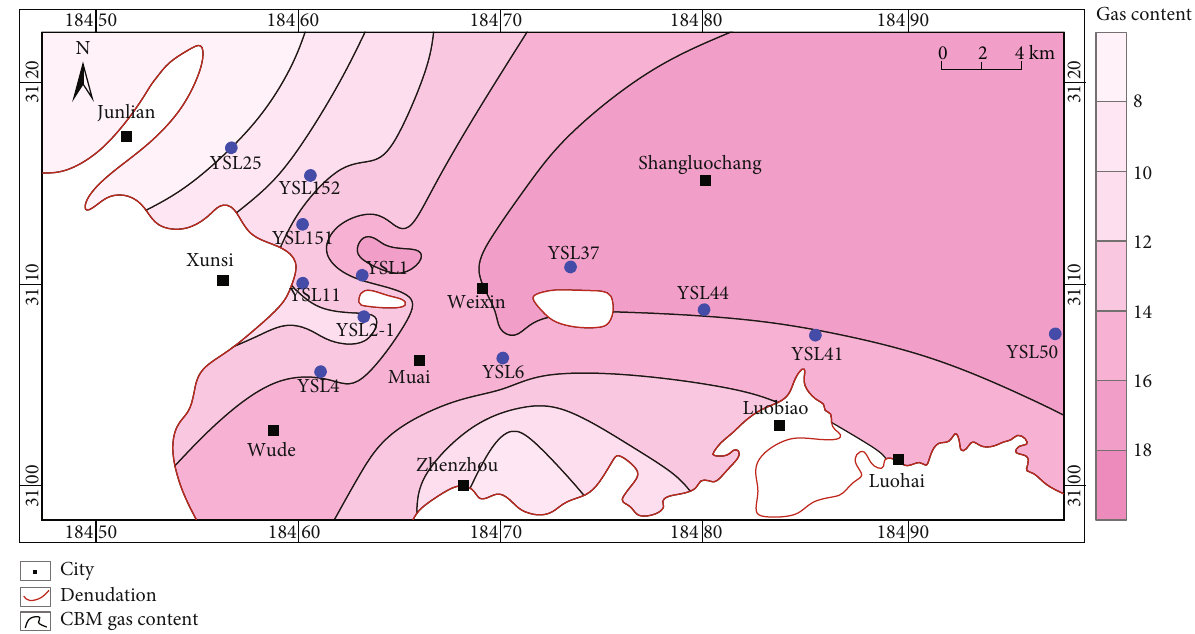
+ C 2 3 coal seam in the Junlian mine